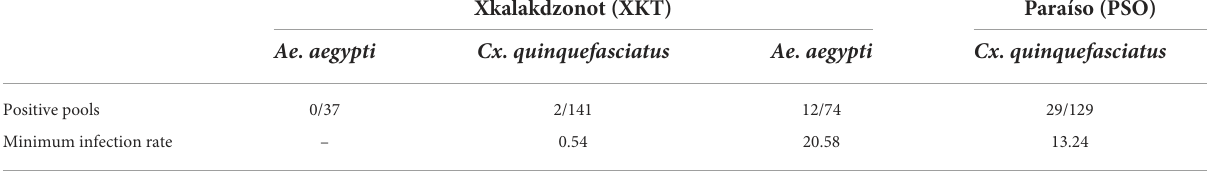
TABLE 6 Pools and MIR of Ae. aegypti and Cx. quinquefasciatus positive for Flavivirus in two Mayan communities of Yucatan,